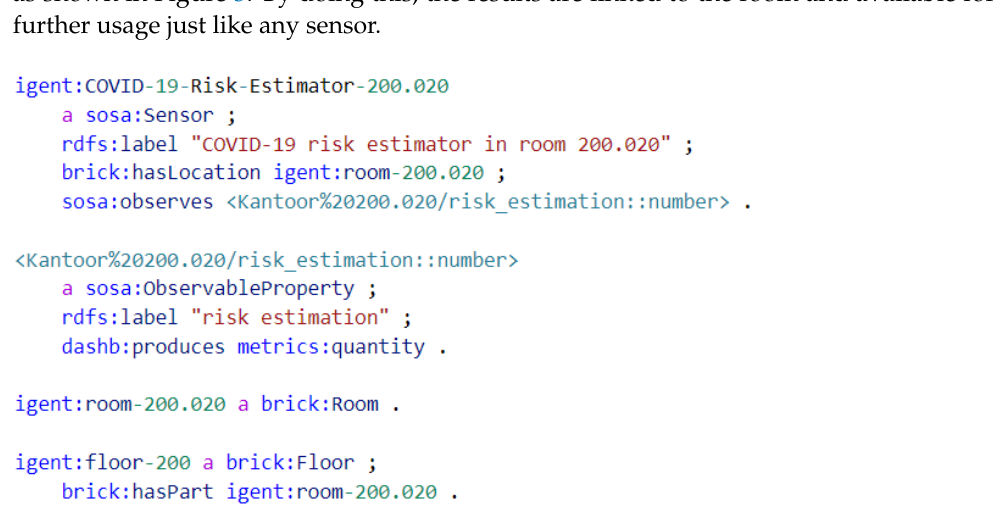
Figure 3. Semantic annotation in Turtle format of a COVID-19 risk estimator, describing it as a (virtual) sensor with a location and the COVID-19 aerosol transmission risk estimation as observed